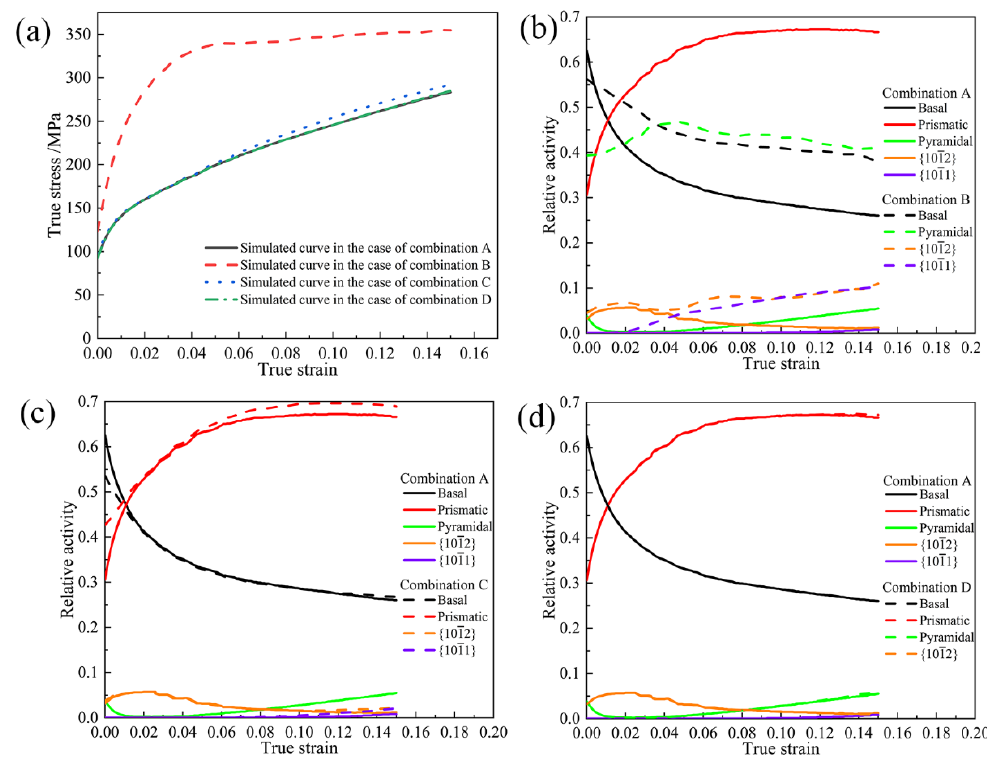
Figure 3. ( a ) The predicted stress–strain curves of AZ31 magnesium alloy under IPT along TD; ( b – d ) the corresponding slip and twinning activities predicted by VPSC modeling in the cases of combination B, combination C, and combination D, respectively.